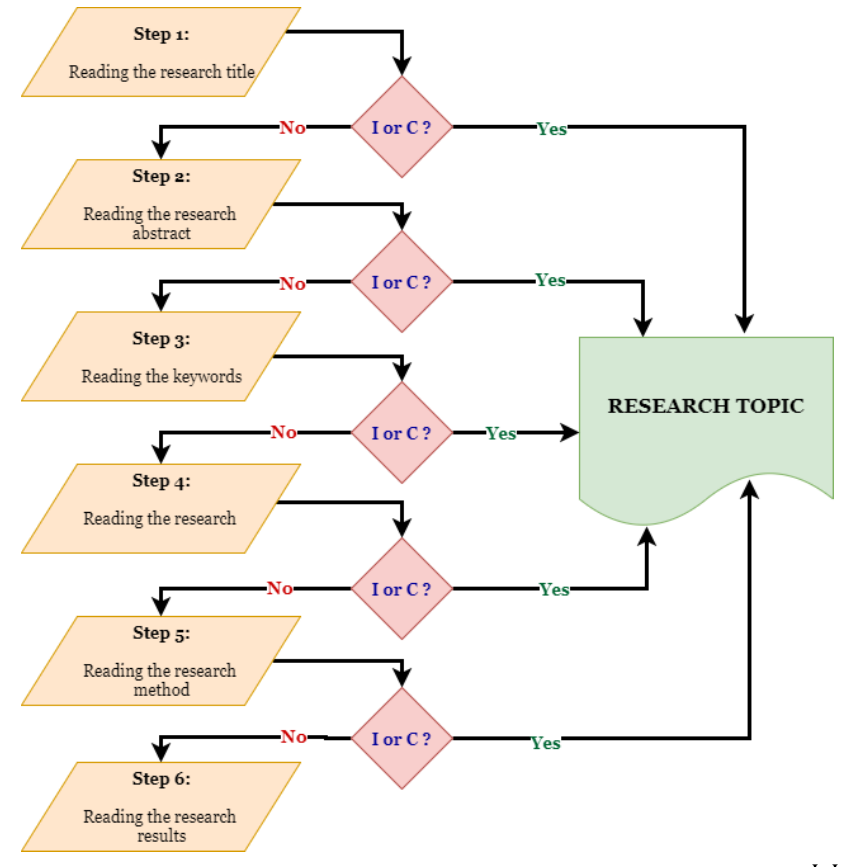
Figure 3 . The research topic determining the